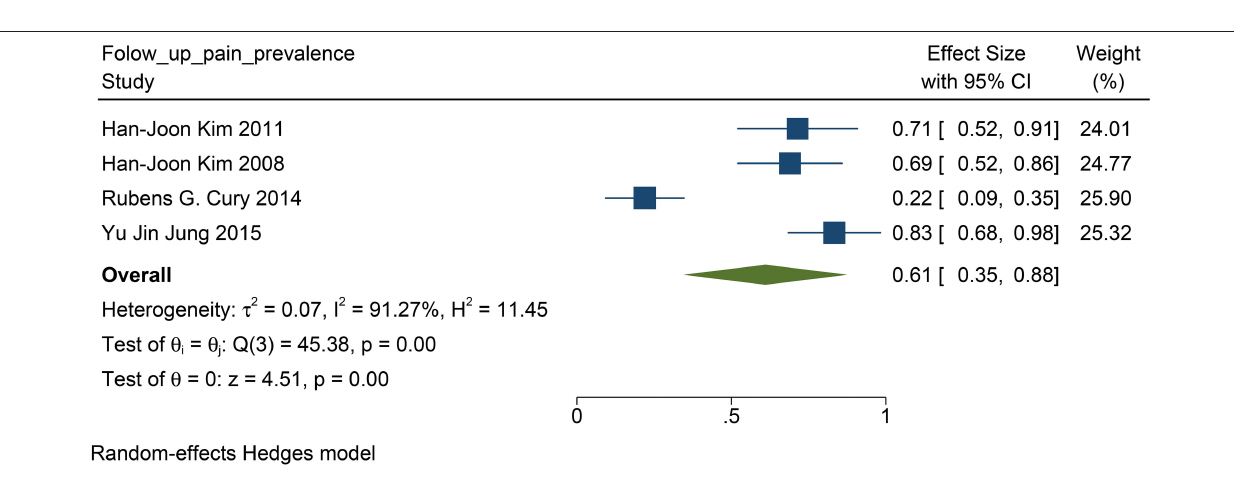
FIGURE 7 | The pain prevalence in patients with PD at follow-up visit: the pain prevalence in patients with PD at the follow-up is 61%. PD, Parkinson’s